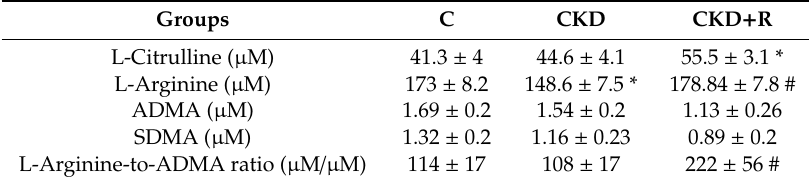
N = 7–8 / group; * p < 0.05 vs. C; # p < 0.05 vs.